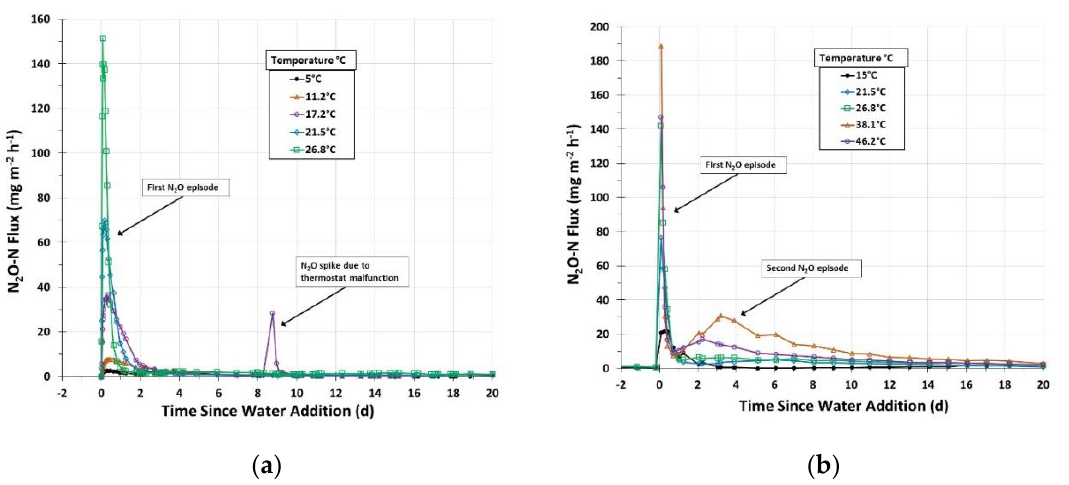
Figure 3. N 2 O – N fluxes from feedyard manure following two simulated rainfall applications. Emissions were baseline until H 2 O was added, and then a large peak was observed in all chambers: ( a ) Days 1 – 20, and ( b ) Days 20 – 59, where temperatures were increased in three chambers and a second, longer – term N 2 O peak was observed that was related to temperature. Source: Parker et al. [3].